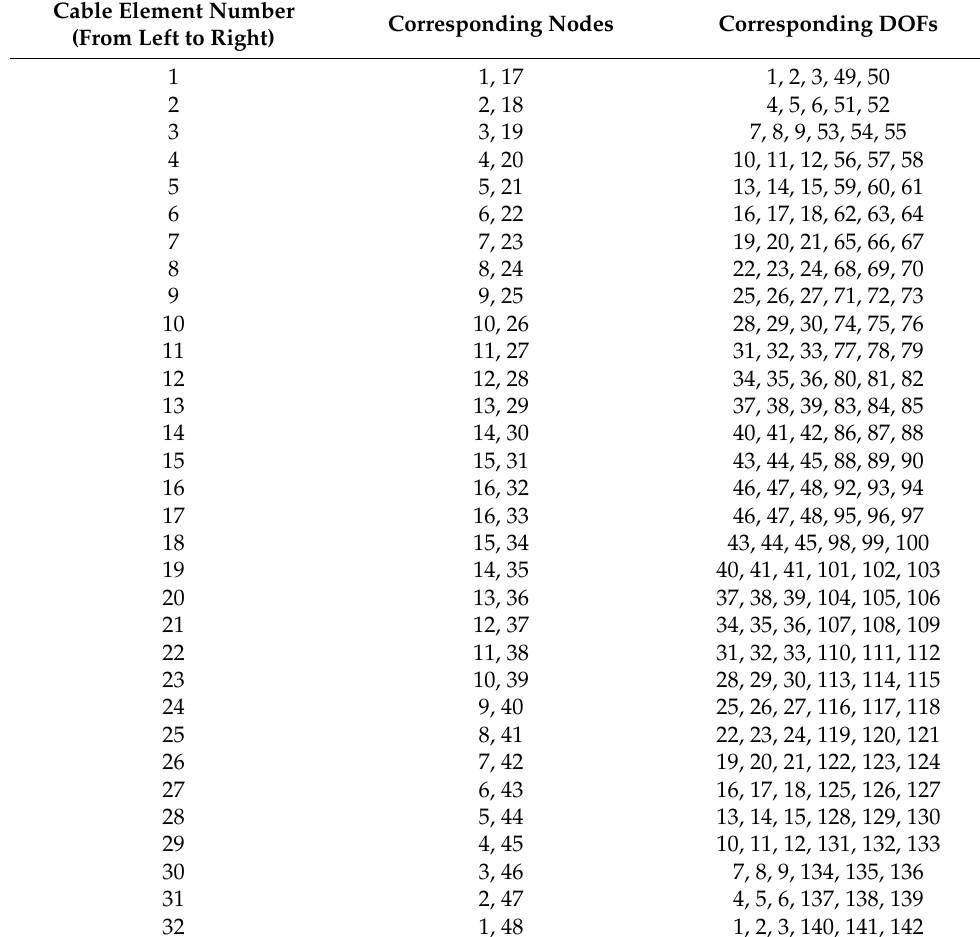
Table 2. Cable elements with corresponding nodes and DOFs. Cable Element Number Corresponding Nodes Corresponding (From Left to Right)